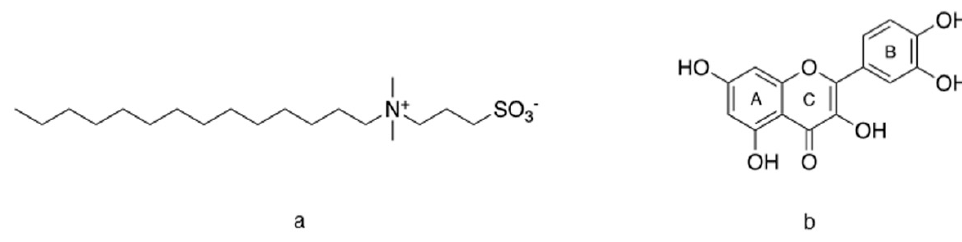
Figure 1. Molecular structure of ( a ) 3-(N,N-dimethyltetradecylammonio)propane-1-sulfonate (SB3-14), and ( b ) quercetin.